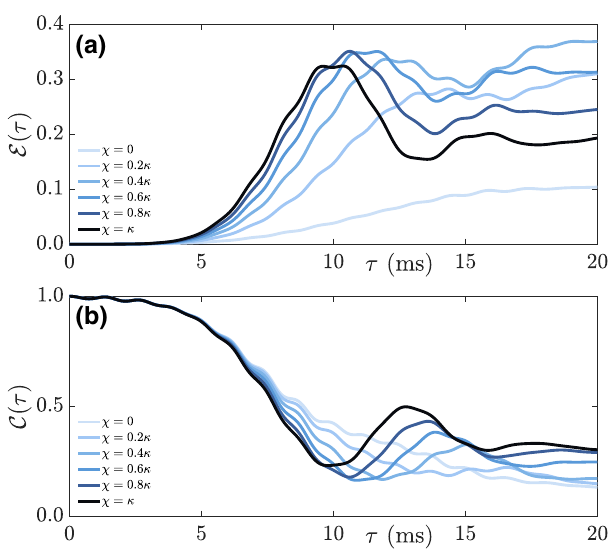
FIG. 11. Starting in the charge-proliferated state | . . . , 0, 1, 0, 1, 0, 1, 0, . . . (cid:7) , we perform the inverse of the adiabatic ramp protocol depicted in Fig. 3 for various values of χ/κ (see legends). (a) The ensuing dynamics of the electric